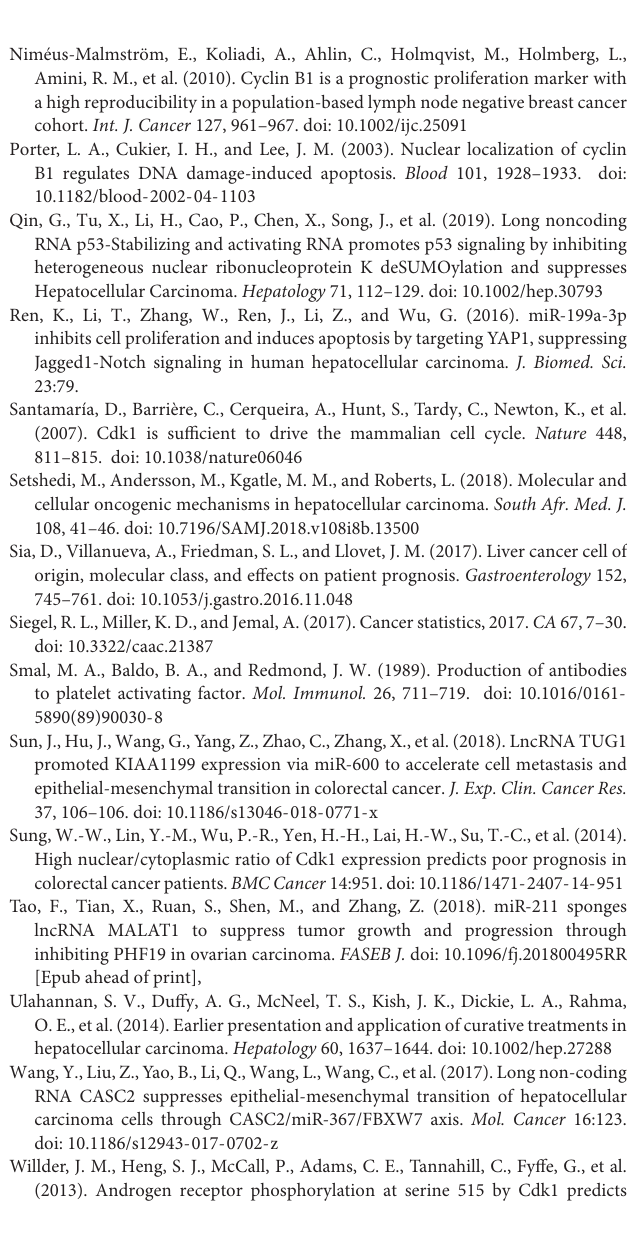
TABLE S1 | 230 differential genes screened by differential analysis of GES62232 dataset in GEO